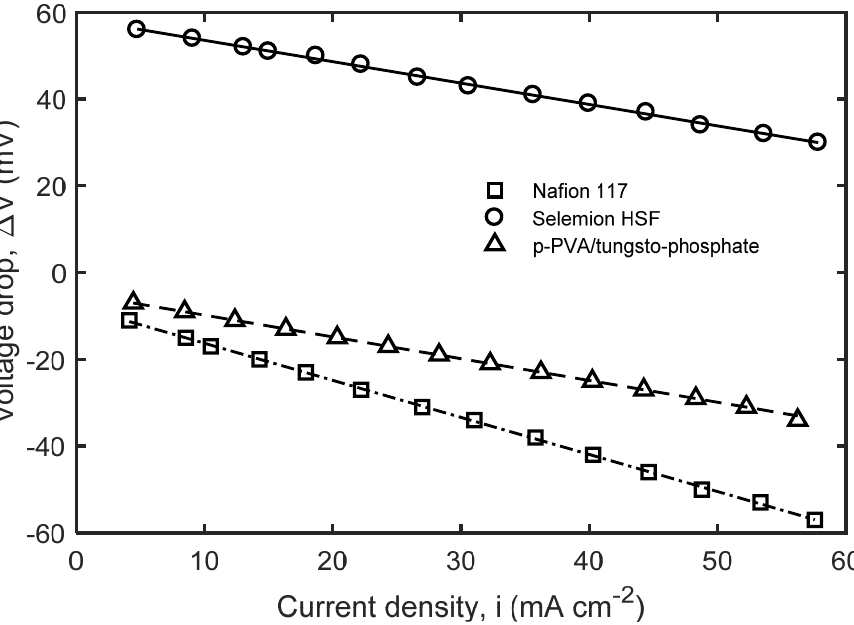
Figure 7. Voltage drop as a function of current density for different membranes used in this study.